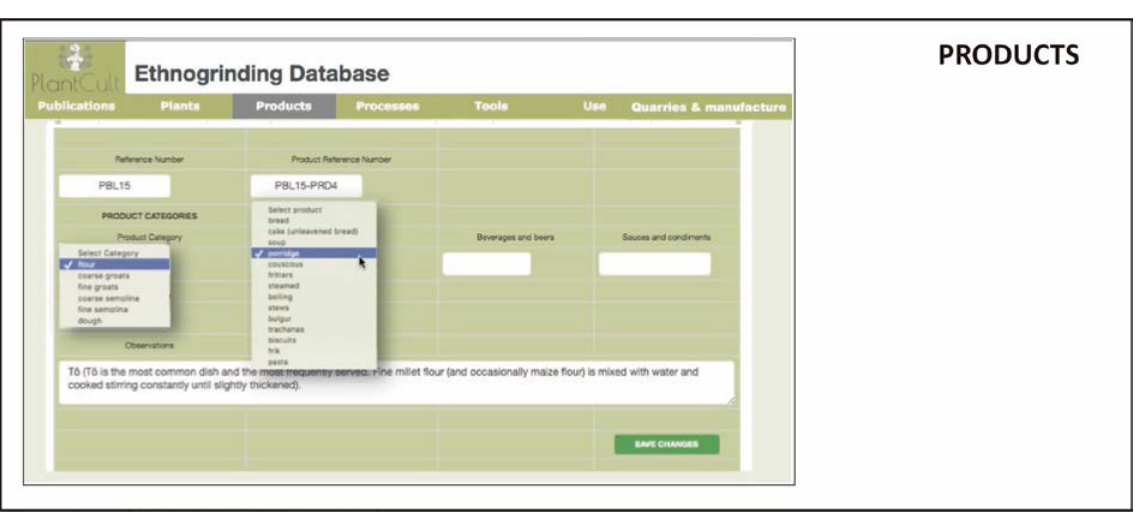
Figure 6. The Products